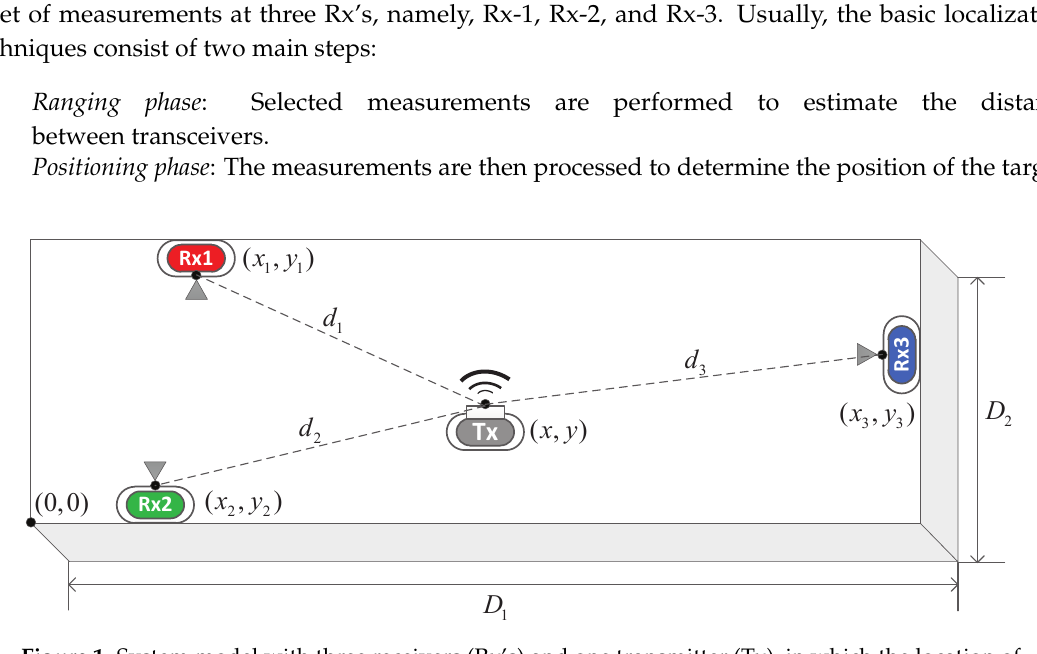
Figure 1. System model with three receivers (Rx’s) and one transmitter (Tx), in which the location of the Tx is to be estimated through the three